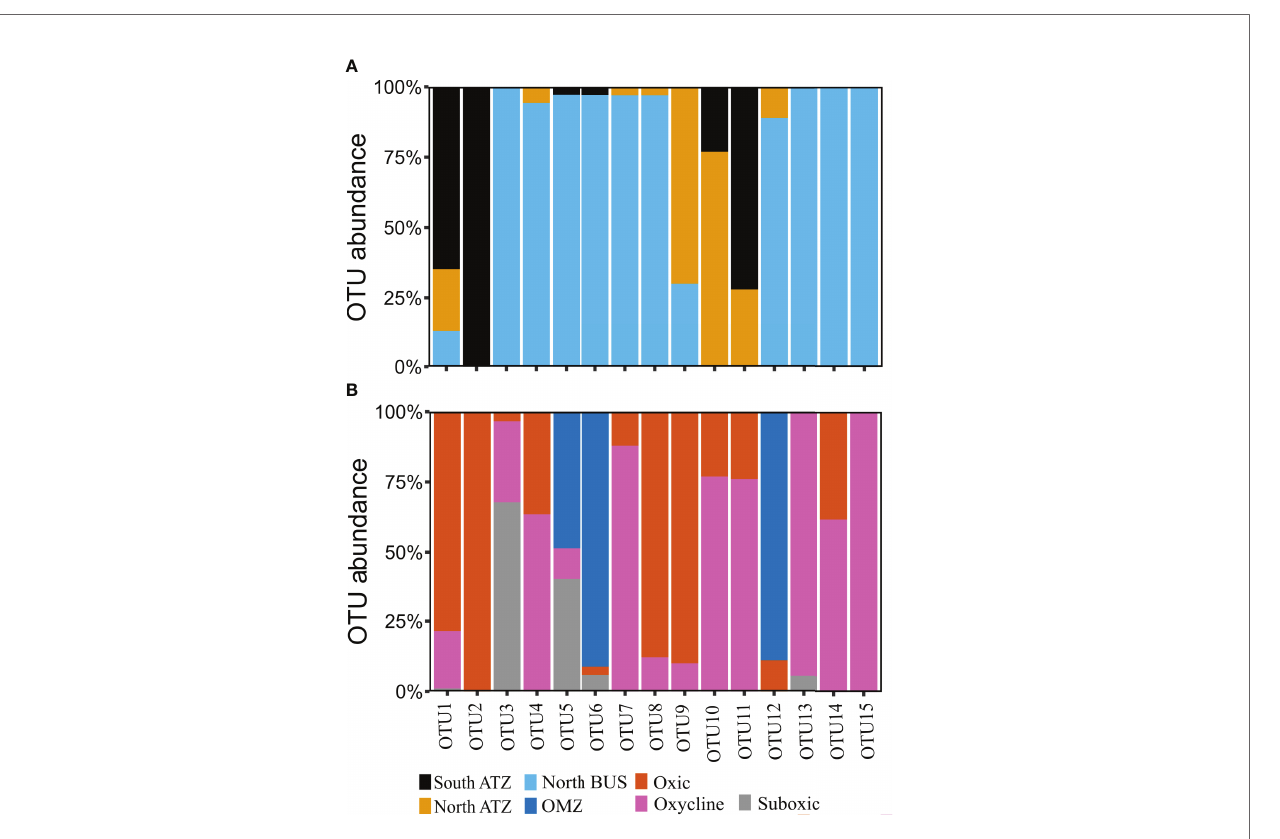
FIGURE 3 | Histogram of the 15 most abundant OTUs (above 10 sequences) divided by location (A) and O 2 feature (B) . OTUs were de fi ned at a threshold of 3% nucleotide differences and are presented in descending abundance with OTU1 being the most abundant. ATZ stands for Angola Tropical zone and BUS for Benguela Upwelling